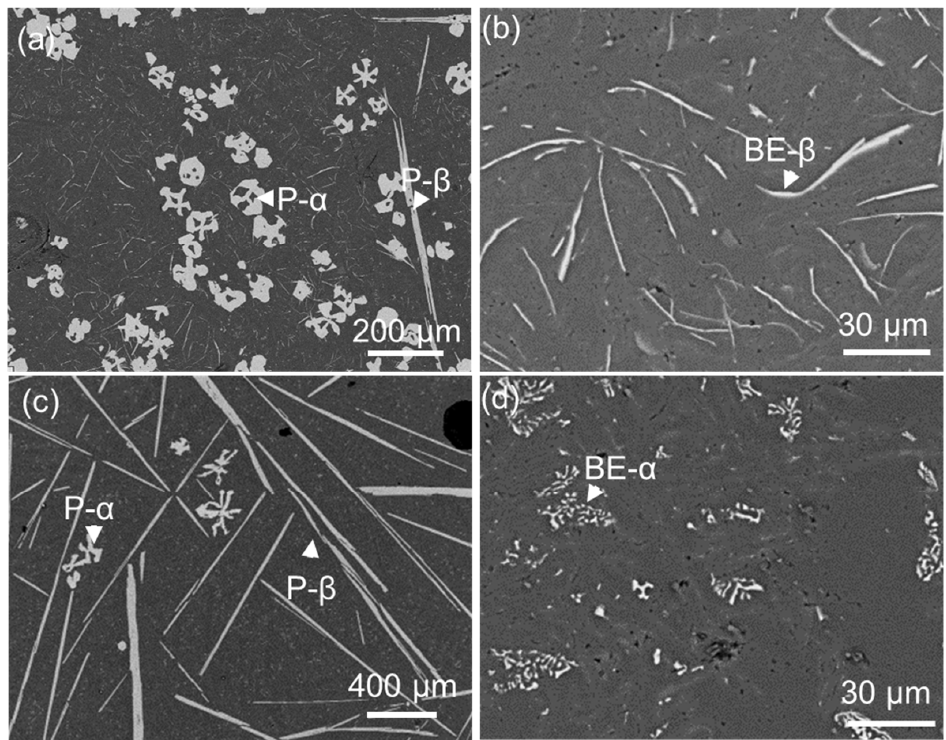
Figure 7. SEM-BSE images showing the as-cast microstructure of Al-11.7Si-0.6Mn-2.8Fe alloy so- lidified at 3.5 K/s. ( a ) Without grain refiner addition, the primary FIMCs are mainly α‐ Al 15 (Fe, Mn) 3 Si 2 with a few primary β -Al 5 FeSi; ( b ) eutectic area from ( a ) contains the plate-like binary eutec- tic β -Al 5 FeSi; ( c ) with 1000 ppm grain refiner addition, the primary FIMC becomes β -Al 5 FeSi, and ( d ) the binary eutectic area contains Chinese script α -Al 15 (Fe,Mn) 3 Si 2 . This suggests that the phase competition of primary FIMCs affects the subsequent formation of the BE ‐ FIMCs.